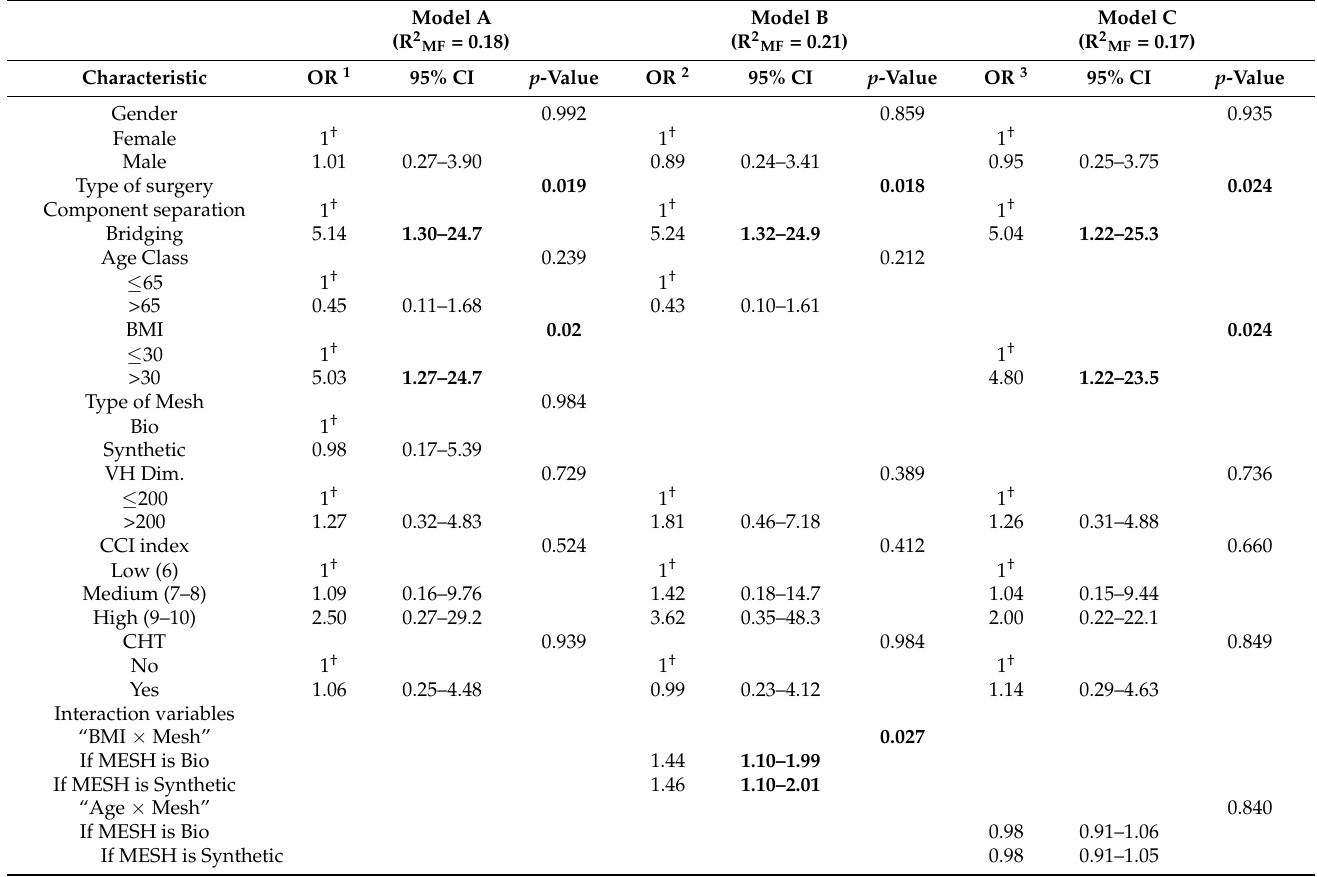
Table 3. Multivariate logistic analysis of VH recurrence risk.